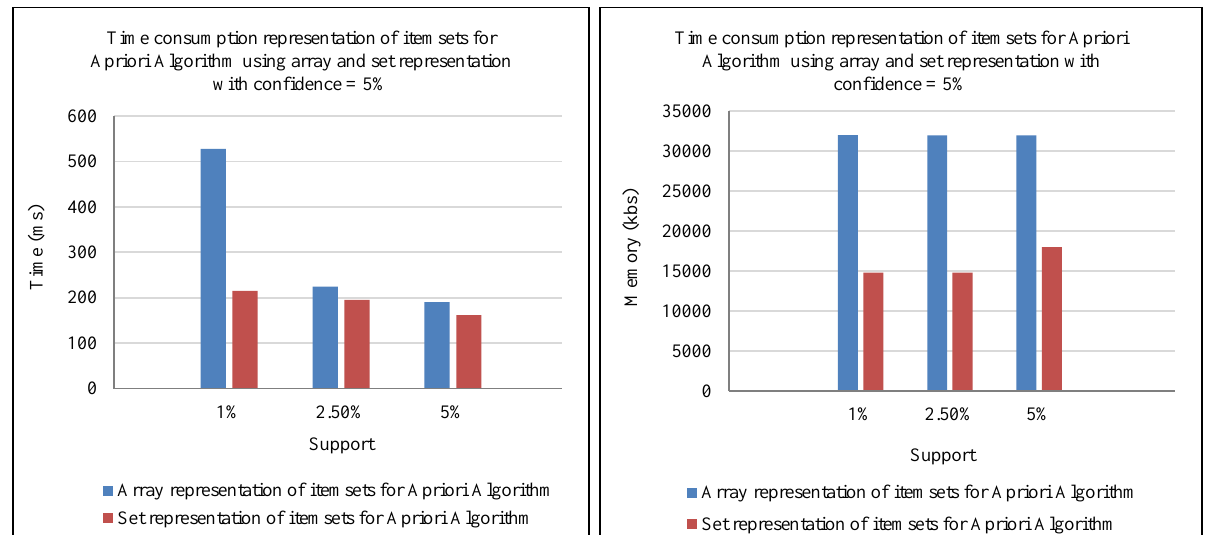
Figure 8. Time and memory consumption of Apriori Algorithm using set and array representation with confidence= 5%.